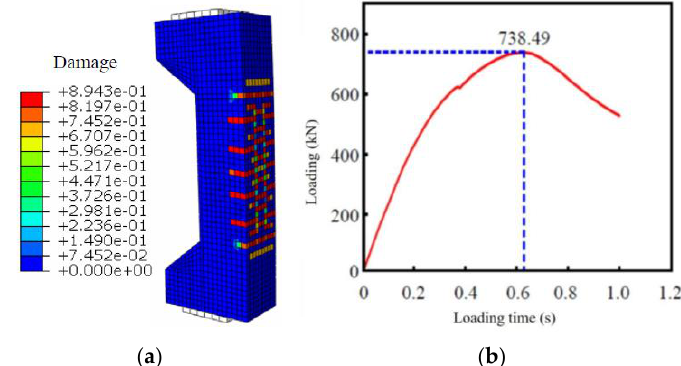
Figure 15. Numerical test results of typical specimens. ( a ) Model cracking under tension; ( b )Ultimate load carrying capacity at model destruction.